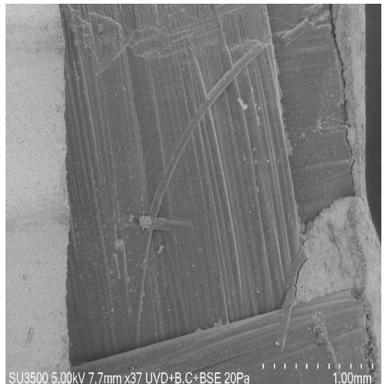
SEM UVD + B.C.+BSE image of edge zone of a C/C sample coated by Al-oxide based varnish enriched by 1 wt% of Si-oxide nanosphere inclusion.